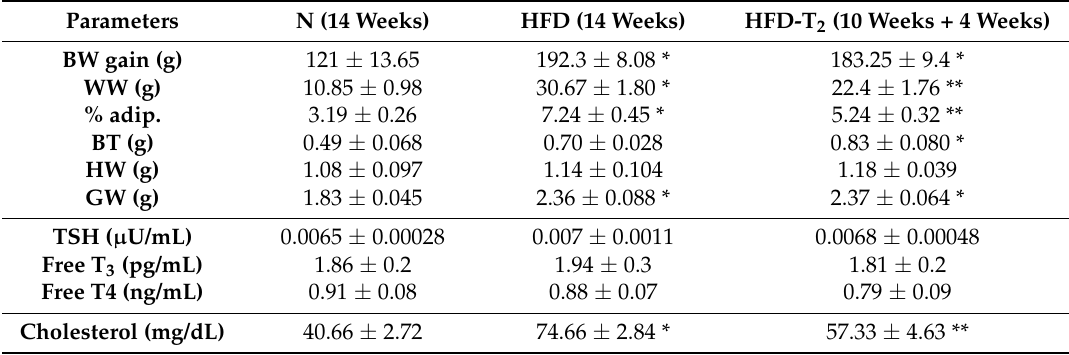
Table 1. Body weight gain together with WAT, BAT, heart, muscle weights and serum TSH, FT3, FT4 and cholesterol levels in N, HFD and HFD-T 2